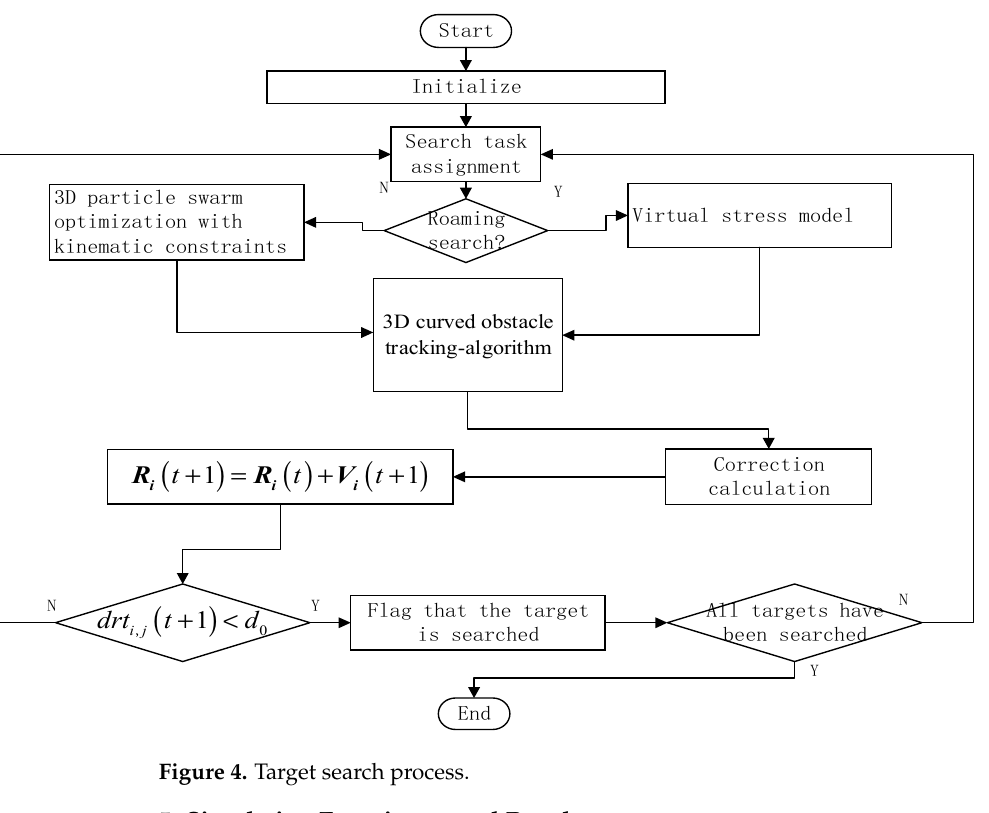
Figure 4. Target search